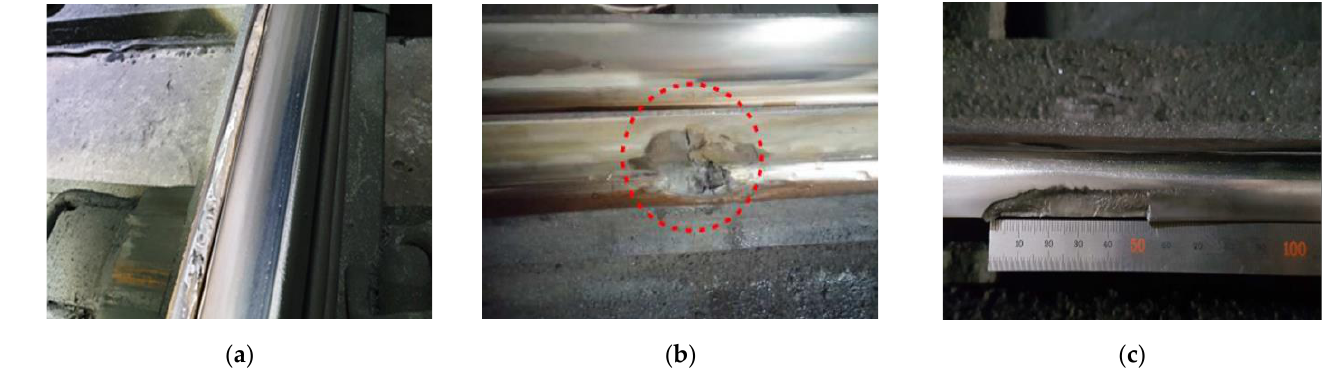
Figure 4. Types of rail damage in a switch panel: ( a ) non-optimal contact and rolling contact fatigue damage; ( b ) local damage of switch toes (1); and ( c ) local damage of switch toes (2).